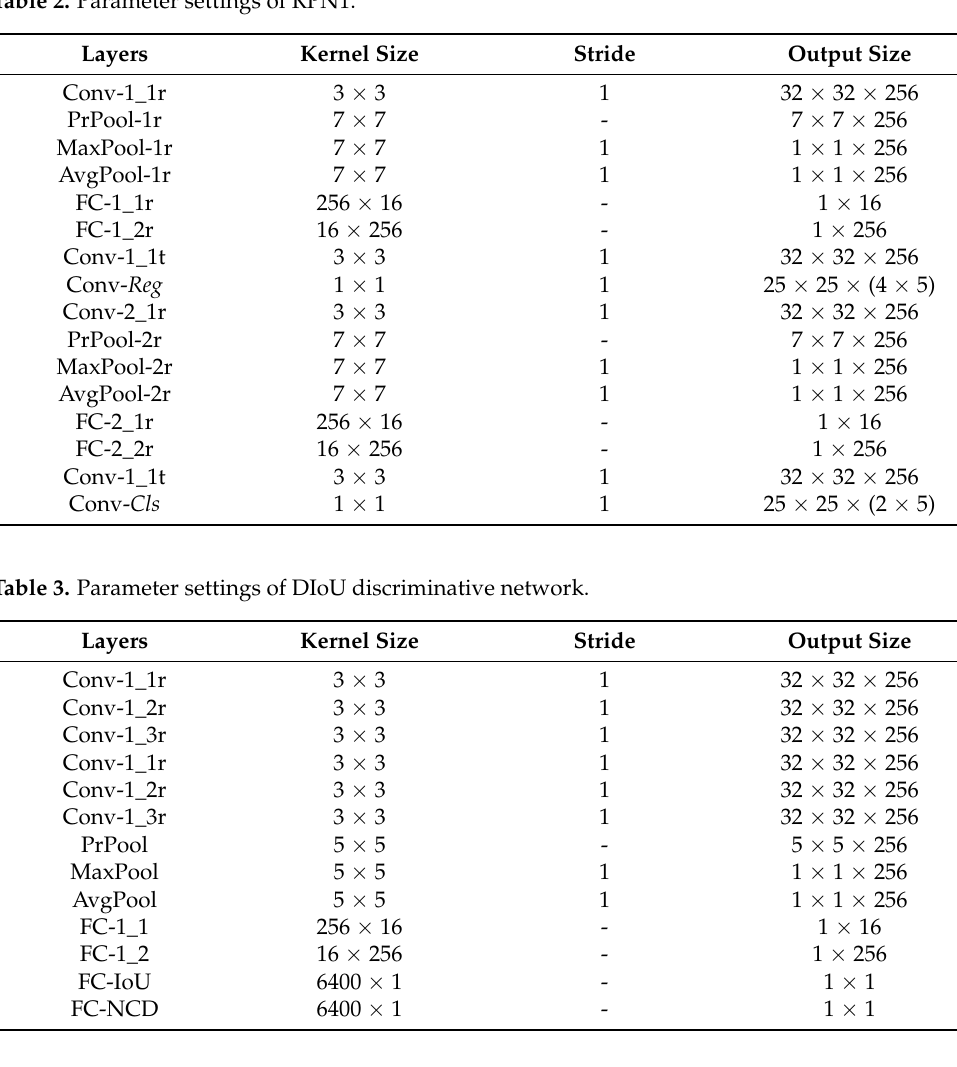
Table 2. Parameter settings of RPN1.